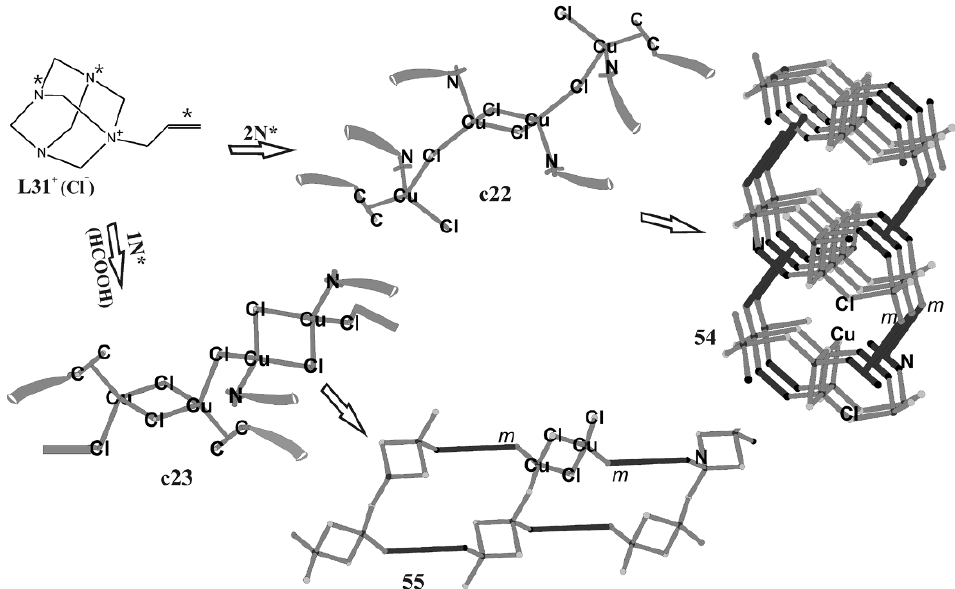
Figure 11. Structural genesis of C22 and C23 fragments in 54 and 55